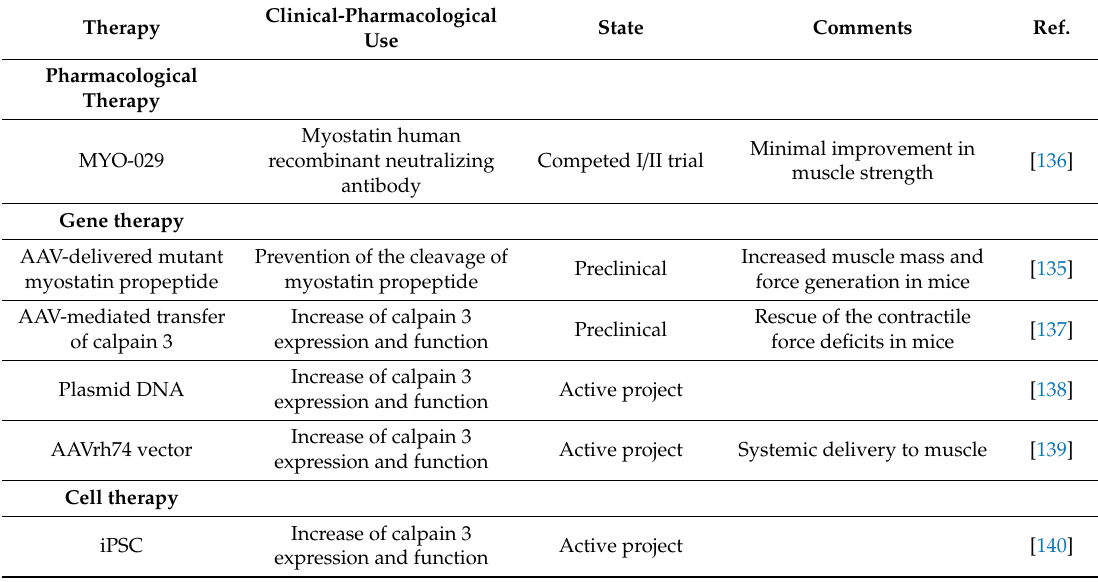
Table 1. Therapeutic strategies for limb-girdle muscular dystrophy recessive 1